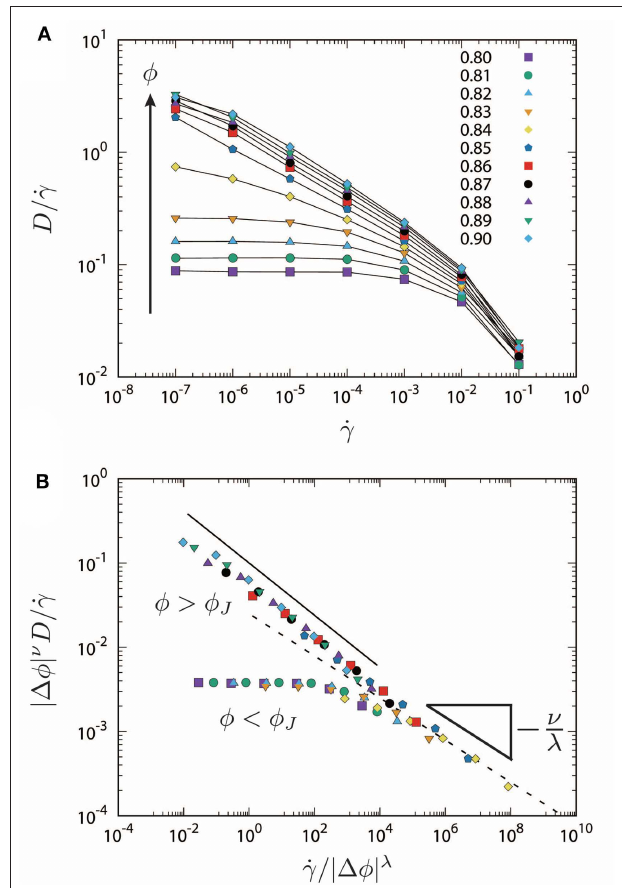
FIGURE 3 | (A) The diffusivity over the shear rate, D / ˙ γ , as a function of ˙ γ , where φ increases as indicated by the arrow and listed in the legend. (B) Scaling collapses of the diffusivity, where 1φ ≡ φ − φ J . The critical exponents are given by ν = 1.0 and λ = 4.0, where slopes of the dotted and solid lines are − ν/λ and − 0.3,